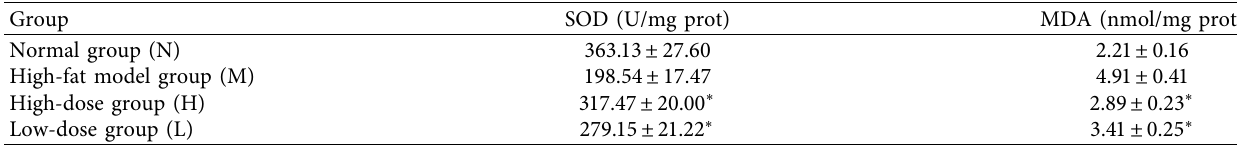
Table 5: Determination results of SOD and MDA in the liver of KM mice in each group.